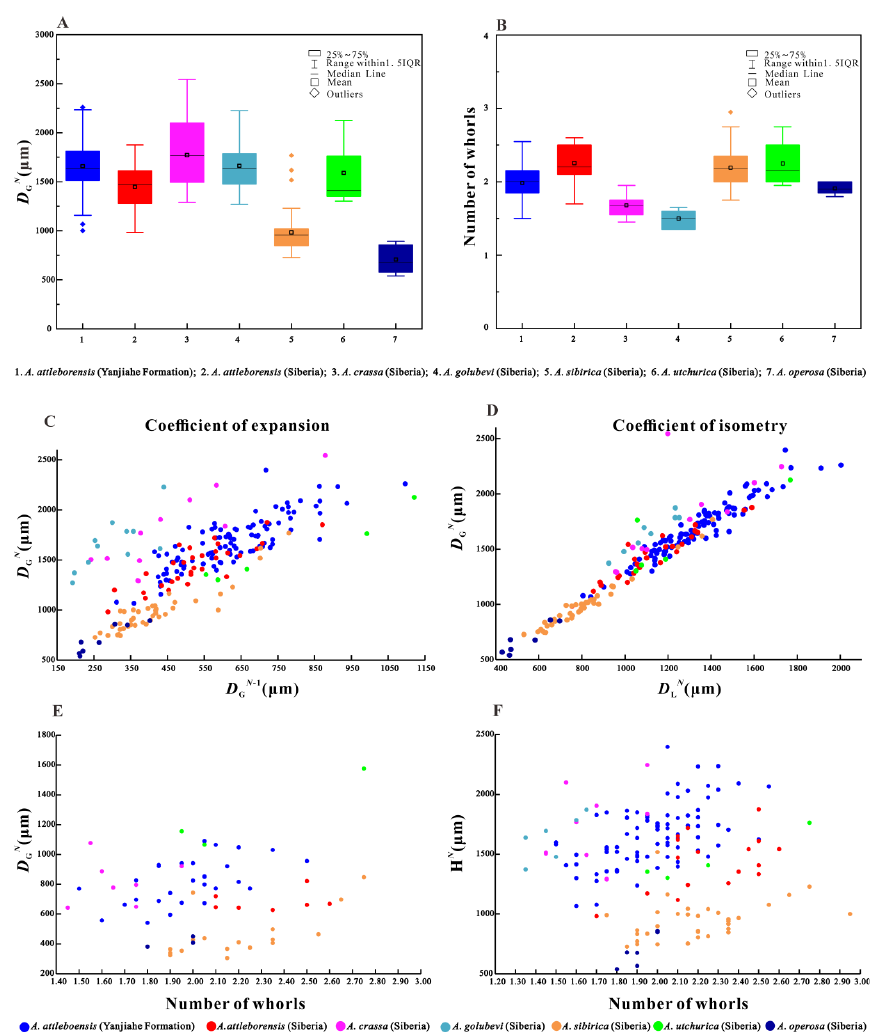
Figure 6. Morphological parameter analyses of Aldanella . ( A ), box-plot of greater shell diameter, including A. attleborensis (Yanjiahe Formation, N = 108), A. attleborensis (Siberia, N = 31), A. crassa (Siberia, N = 11), A. golubevi (Siberia, N = 11), A. sibirica (Siberia, N = 41), A. utchurica (Siberia, N = 5), A. operosa (Siberia, N = 8). ( B ), box-plot of number of whorls, including A. attleborensis (Yanjiahe Formation, N = 81), A. attleborensis (Siberia, N = 17), A. crassa (Siberia, N = 10), A. golubevi (Siberia, N = 7), A. sibirica (Siberia, N = 34), A. utchurica (Siberia, N = 4), A. operosa (Siberia, N = 6). ( C ), greater shell diameter/lesser shell diameter ratio showing the coefficient of isometry. ( D ), greater shell diameter at stage of N whorls/greater shell diameter at stage of N -1 whorls ratio, showing the coefficient of expansion. ( E ), linear regression between the number of whorls and the greater shell diameter. ( F ), linear regression between the number of whorls and the shell height. Siberian data from Parkhaev and Karlova [13], tables